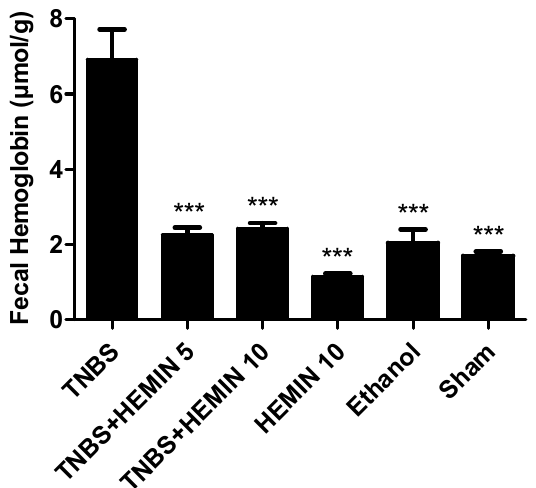
Figure 3. Effect of hemin treatment on fecal hemoglobin in the IBD. Legend: One-way ANOVA for multiple comparisons and Tukey’s post hoc test. *** p < 0.001; compared with TNBS group. ALP has a protective effect on the intestinal system, being responsible for the mucosal defense [16,21]. This marker was measured and compared between all the experimental groups (Figure 4). The highest concentration of ALP was noticed in the TNBS